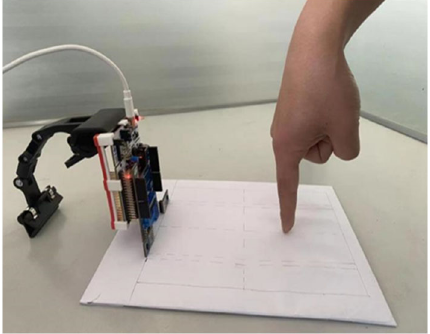
Figure 3. Drawing letters vertically on the flat surface.